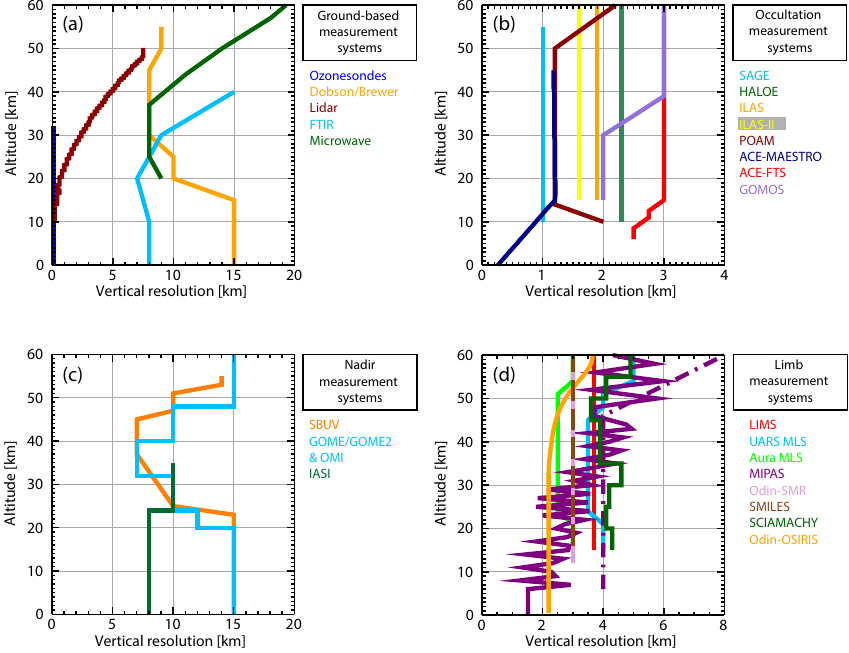
Figure 3. Vertical resolution shown as function of altitude for each of the described instruments systems: (a) ground-based instruments, (b) solar/stellar occultation instruments, (c) nadir-measuring instruments, and (d) limb-measuring instruments. The SMILES profile in panel (d) is shown as a brown dashed line that is plotted on top of the ODIN-SMR (light purple). Note that there are two profiles shown for MIPAS in panel (d) : the solid purple line represents the KIT retrieval, and the dash-dotted purple line represents the Bologna retrieval. The oscillating altitude resolution of the MIPAS KIT profile is a consequence of the evaluation of the averaging kernels on a vertical grid finer than the tangent altitude spacing: the vertical resolution is best at the tangent altitudes and coarsest between the tangent altitudes. Retrieval resolution for the Oxford and ESA processors is comparable to the KIT results; however, a courser grid is used for the retrieval and thus it does not show the oscillating features of the KIT processor. For more detail on the different MIPAS retrievals see Sect.